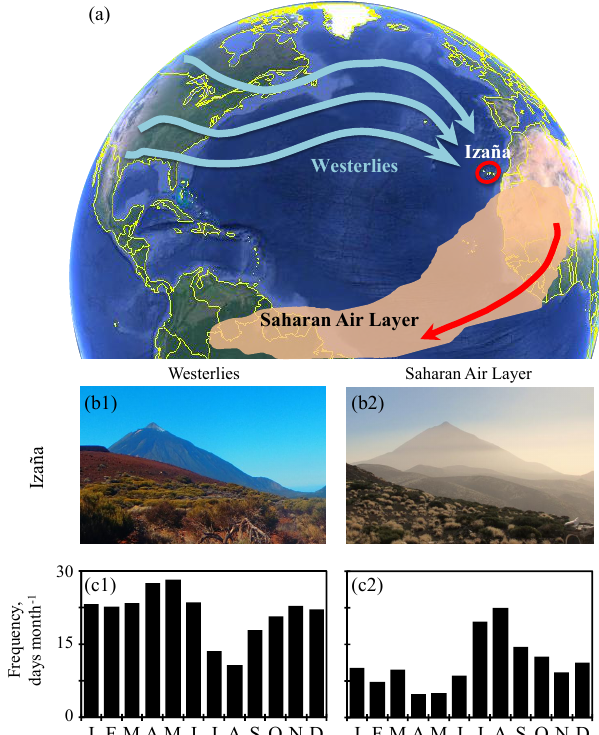
Figure 1. (a) Location of the Izaña Observatory with an illustration of the Saharan Air Layer and the westerlies. (b) View from the Izaña Observatory to the west under the westerly and Saharan Air Layer conditions. (c) Monthly frequency (number of days per month) of westerly and Saharan Air Layer at Izaña based on